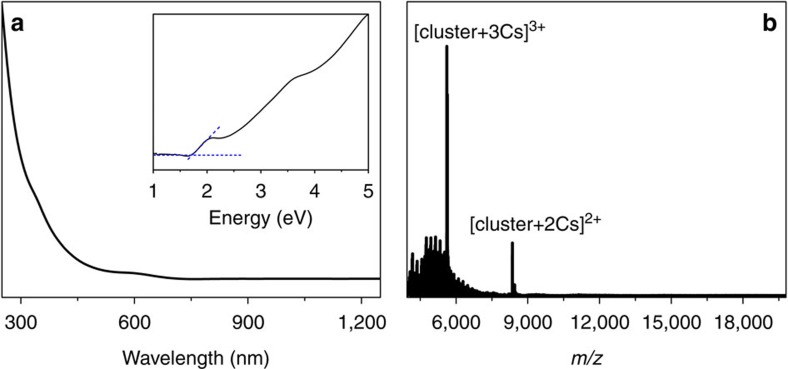
Characterization of Au60S6(SCH2Ph)36.Ultraviolet-visible-near-infrared spectrum (a) and electrospray ionization mass spectrometry (ESI-MS) (positive ion mode) spectrum (b) of Au60S6(SCH2Ph)36. The inset of a represents the spectrum on the energy scale.